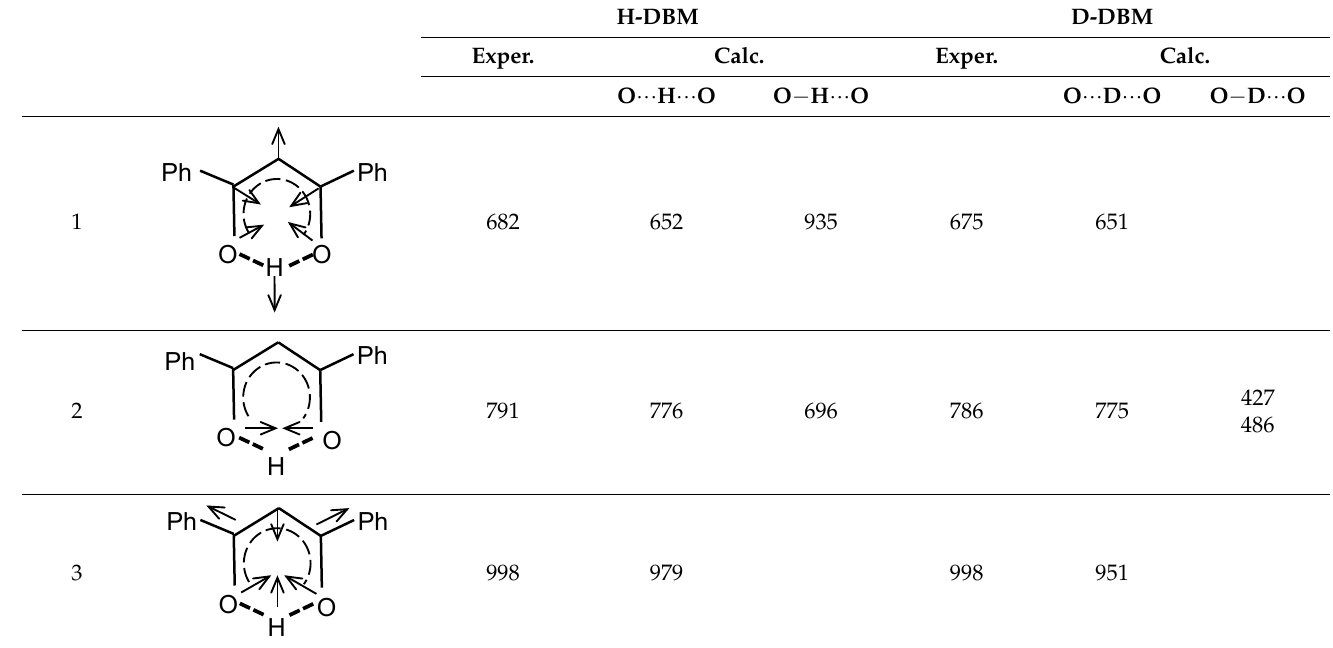
1. Calculated with M06-2X/6-311+G(d,p), the frequency of vibrations in